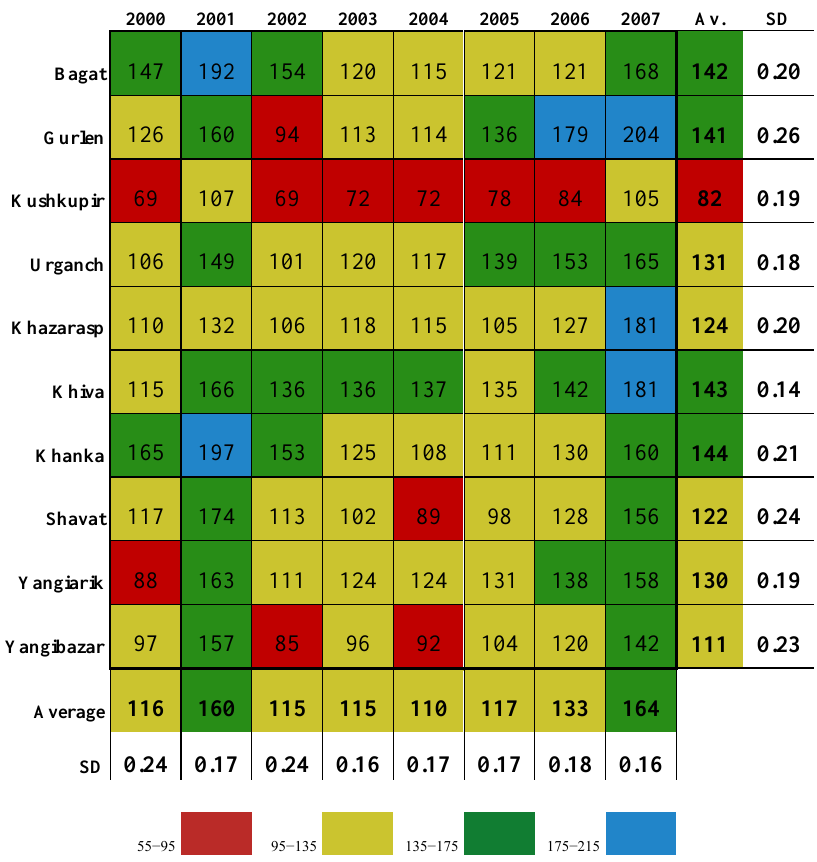
Figure 11. Water productivity [in UZS m −3 ],